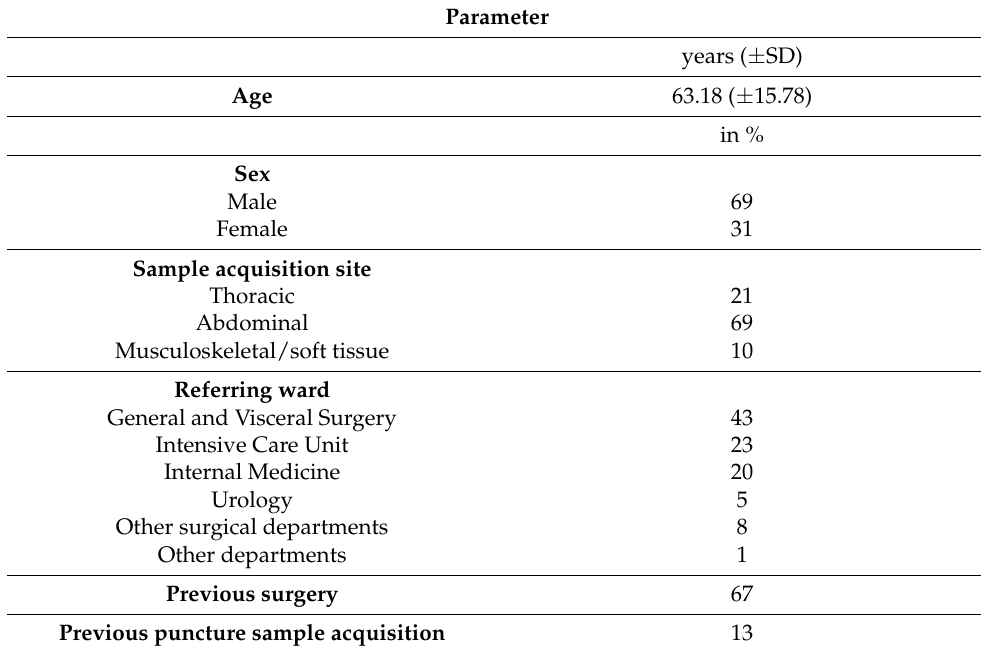
Table 1. Descriptive characterization of the study